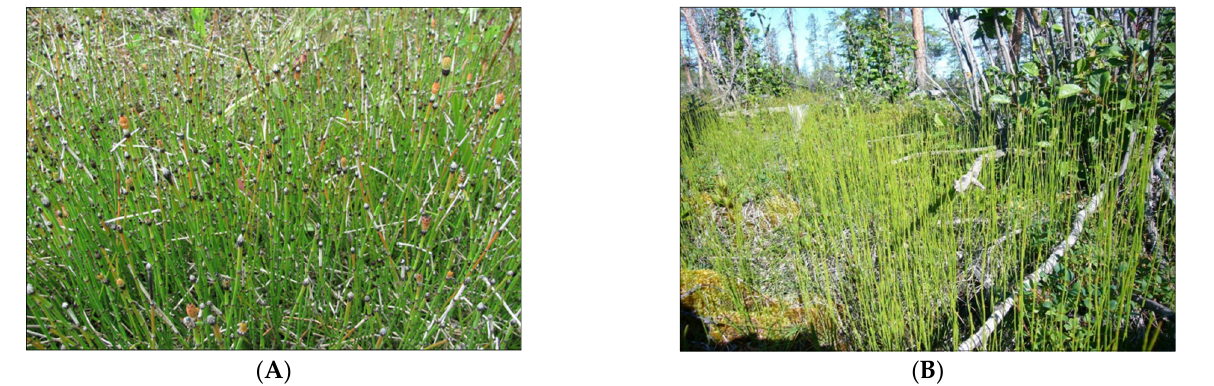
Figure 1. Summer-growing shoots of Equisetum variegatum ( A ) and Equisetum scirpoides ( B ) growing at the Pole of Cold of the Northern Hemisphere.